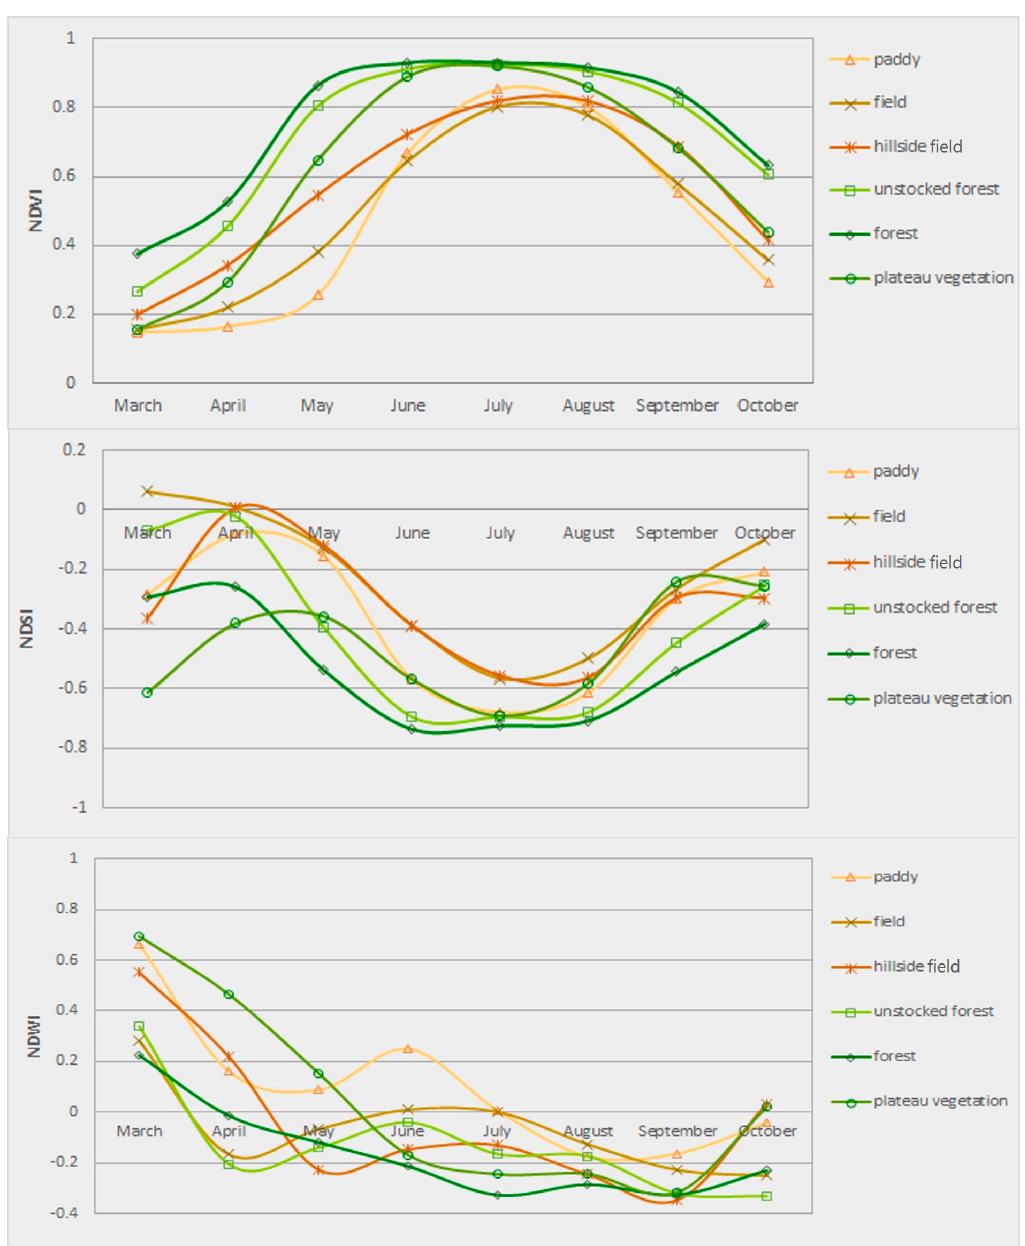
Figure 4. Time series indices of MODIS NDVI, NDSI, and NDWI (derived from RED, NIR, and MIR reflectance) for paddy, field, hillside field, unstocked forest, forest, and plateau vegetation categories. Random samples of 100 points were individually extracted for each type.